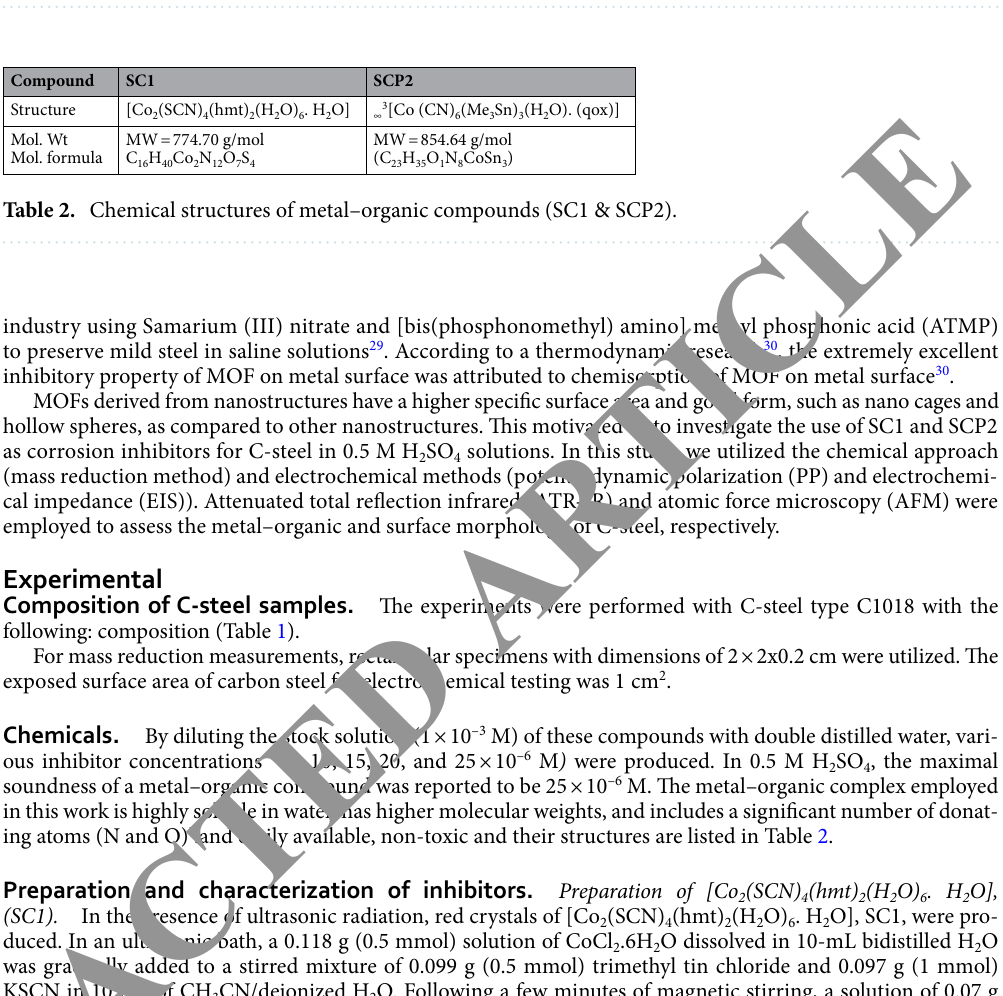
Table 1. C-steel chemical structure.